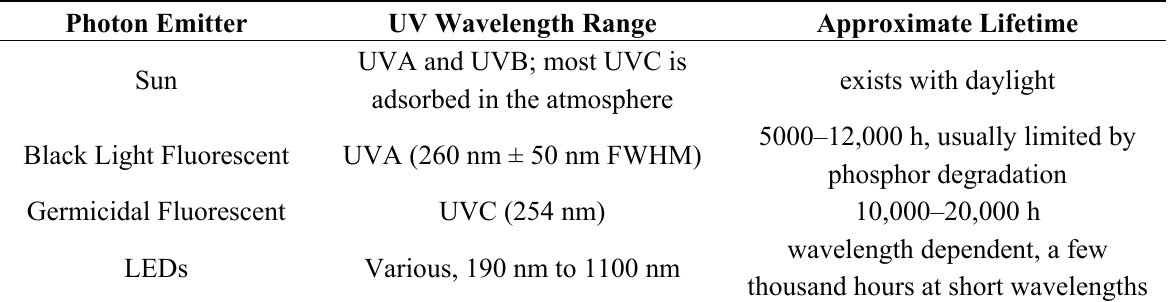
Table 2. Common UV light sources for a UVPCO air